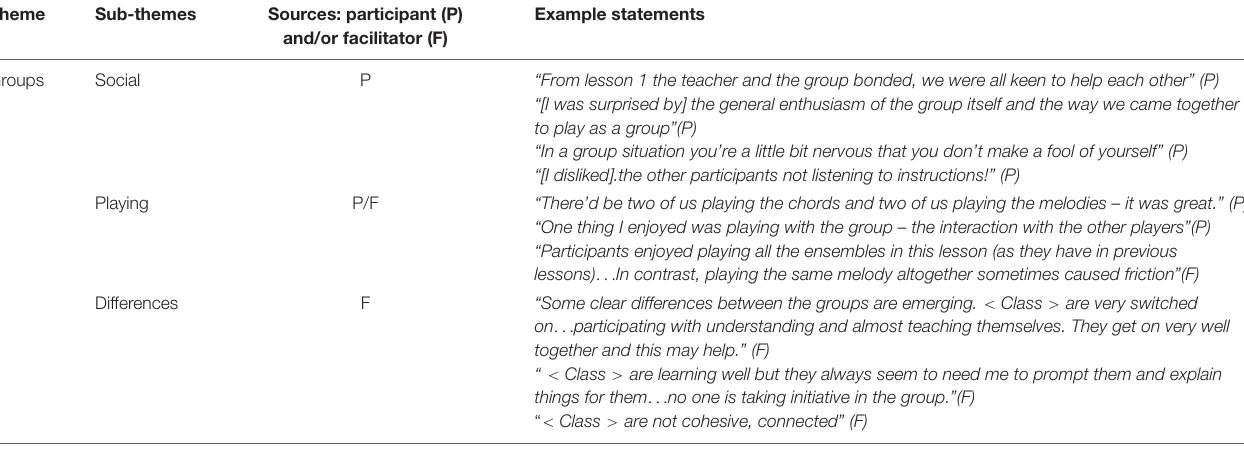
TABLE 6 | Sub-themes and example statements from theme of Benefits